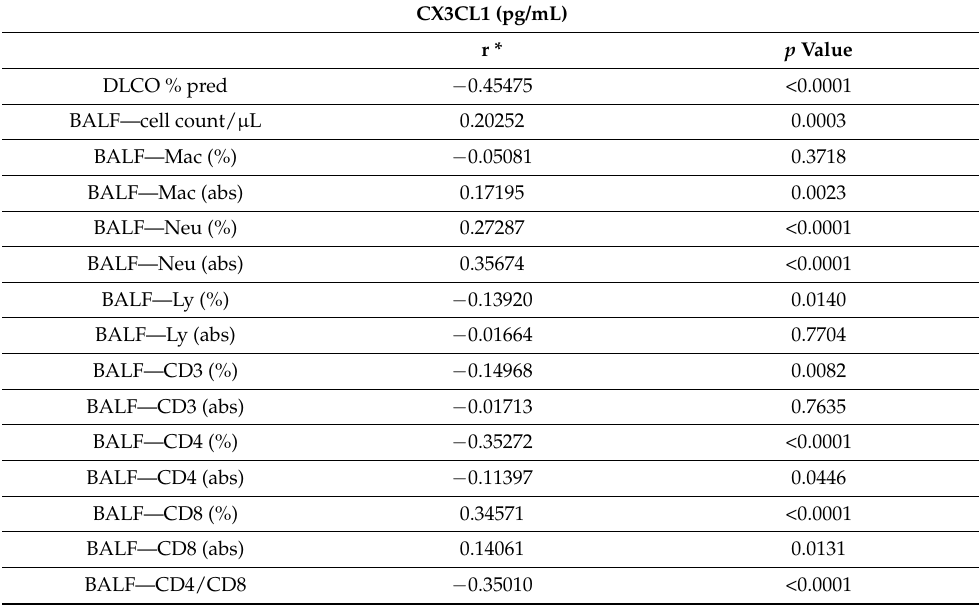
Table 3. Correlation analysis of CX3CL1 with BALF cell count and DLCO (all study groups).